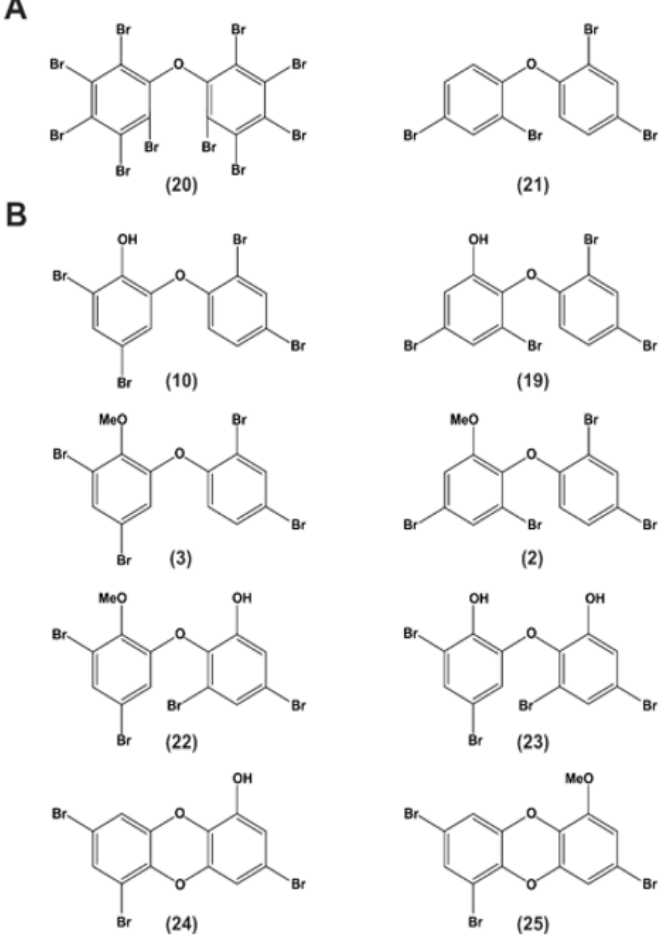
Figure 3. Synthetic and naturally occurring polyhalogenated molecules. Structural similarity between ( A ) synthetic and ( B ) naturally produced marine halogenated phenolic toxins and pollutants (MeO = methoxy-group) (adapted and modified from Agarwal et al., 2017).